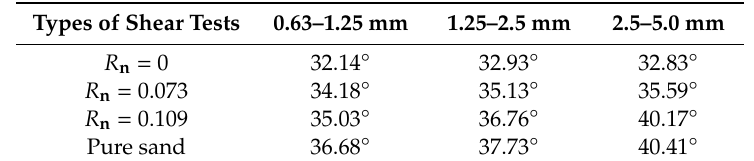
Figure 9. Variation of interface friction angle with di ff erent levels of relative roughness R n . Table 2. Friction angles from shear tests